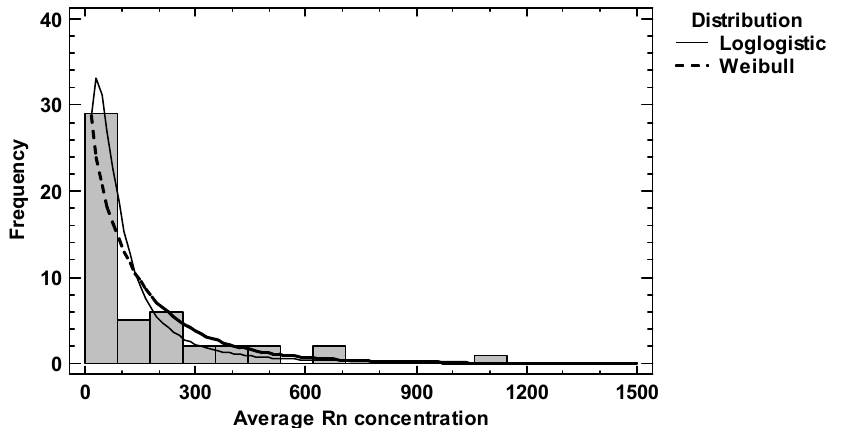
Figure 4. Frequency histogram of indoor radon concentrations (Bq m − 3 ) in the studied institutions in Chisinau region (2021, n = 49).